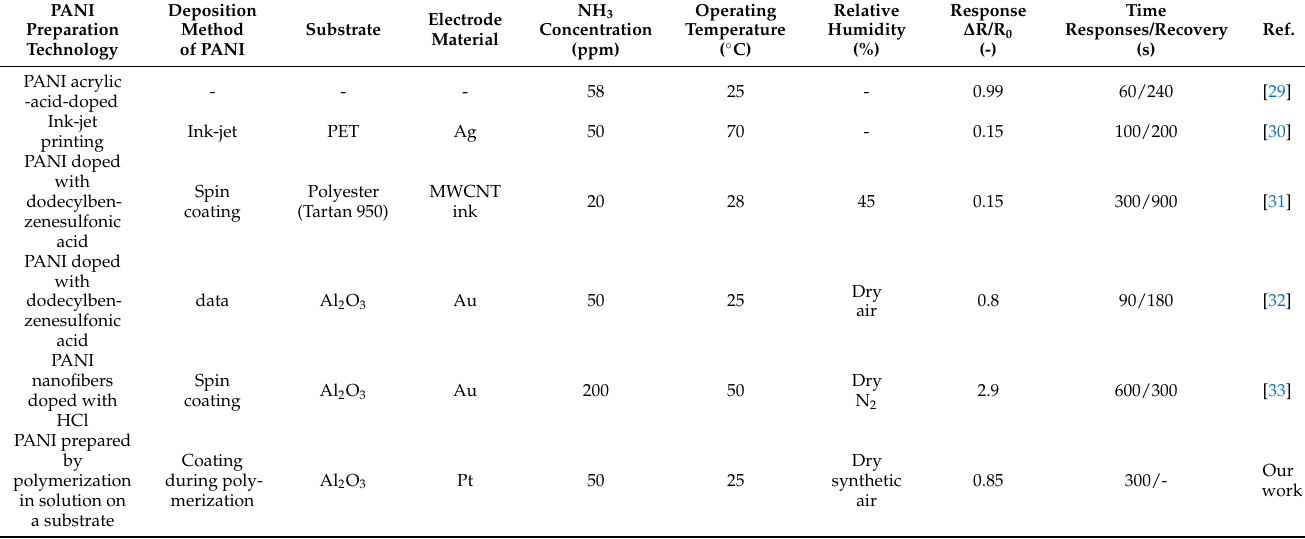
Table 4. Comparison of implemented sensors with other